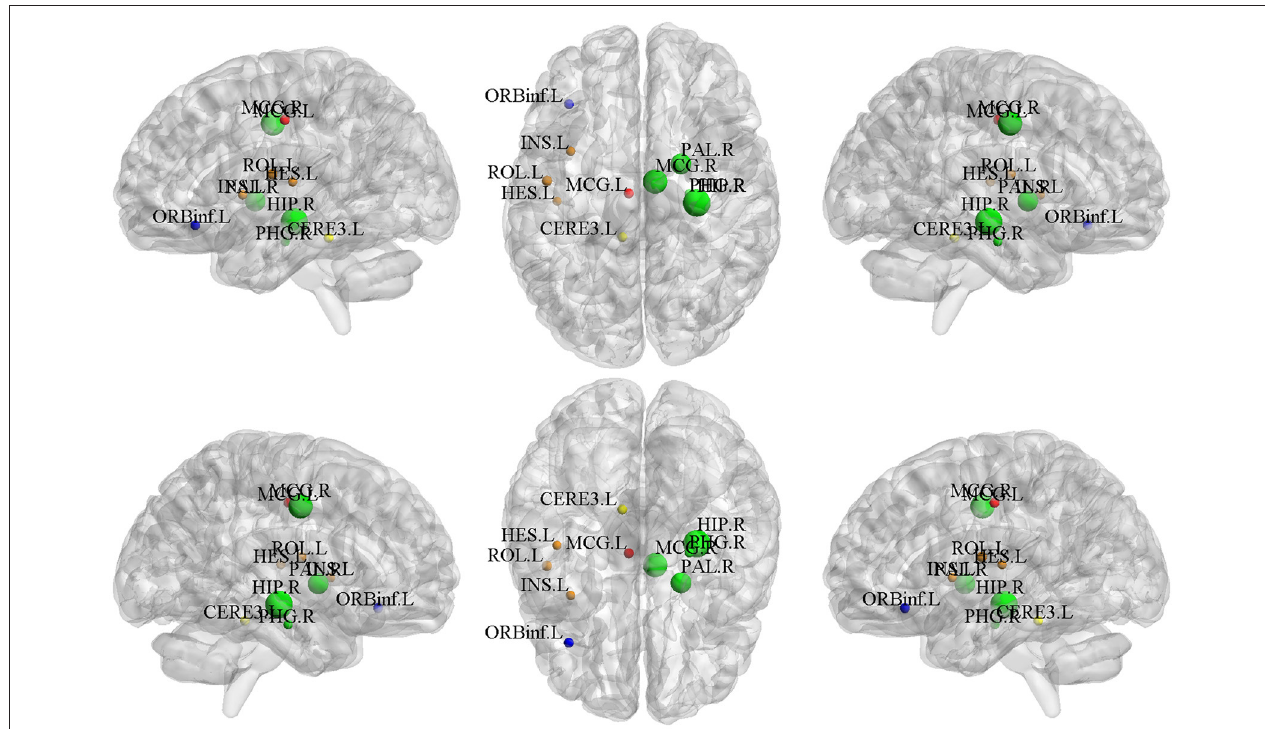
FIGURE 6 | The top 10 ROIs of gray matter volume selected by BN-MSCCA (different colors denote different brain networks).